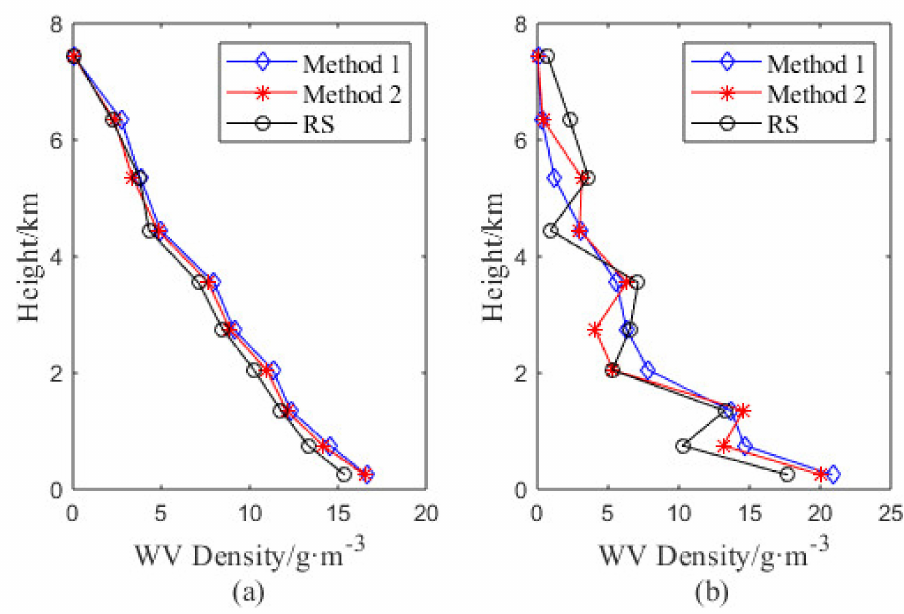
Figure 9. WV profiles obtained by the di ff erent tomographic methods and RS method at UTC 00:00 DOY 245, 2019 ( a ), which is the best WV profile of the experiment epochs, while the worst WV profile is at UTC 00:00 DOY 183, 2019 ( b